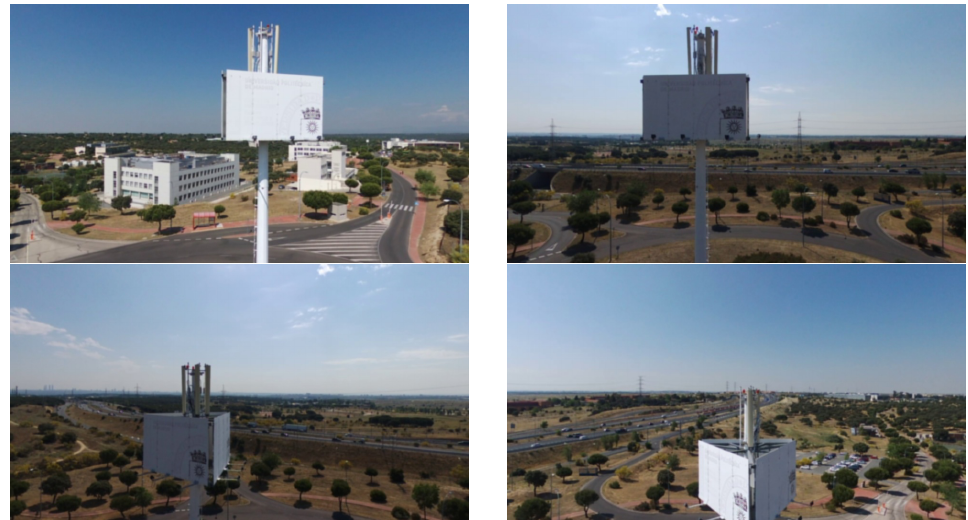
Figure 18. Four in-flight taken pictures from different perspectives along the